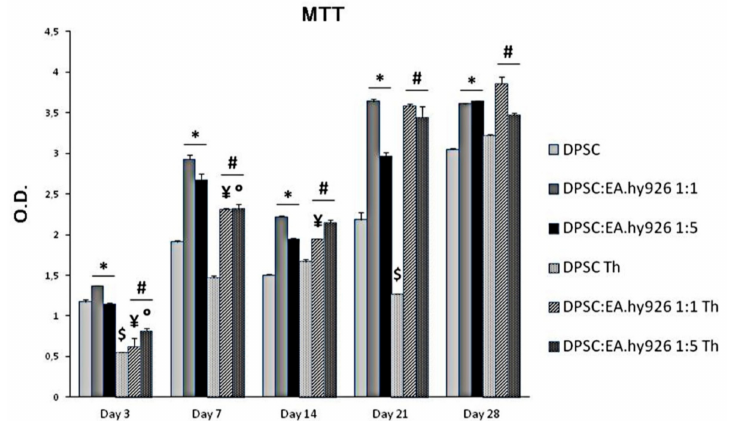
Figure 1. MTT assay in control and Chitlac coated BisGMA / TEGDMA methacrylic thermosets treated DPSC / EA.hy926 coculture for 3, 7, 14, 21, and 28 days. The data shown are the mean ( ± SD) ( n = 3).* DPSC:EA.hy926 1:1 and 1:5 vs. DPSC of the same day of culture, p < 0.05; $ DPSC Th vs. DPSC of the same day of culture, p < 0.05; ¥ DPSC:EA.hy926 1:1 Th vs. DPSC:EA.hy926 1:1 of the same day